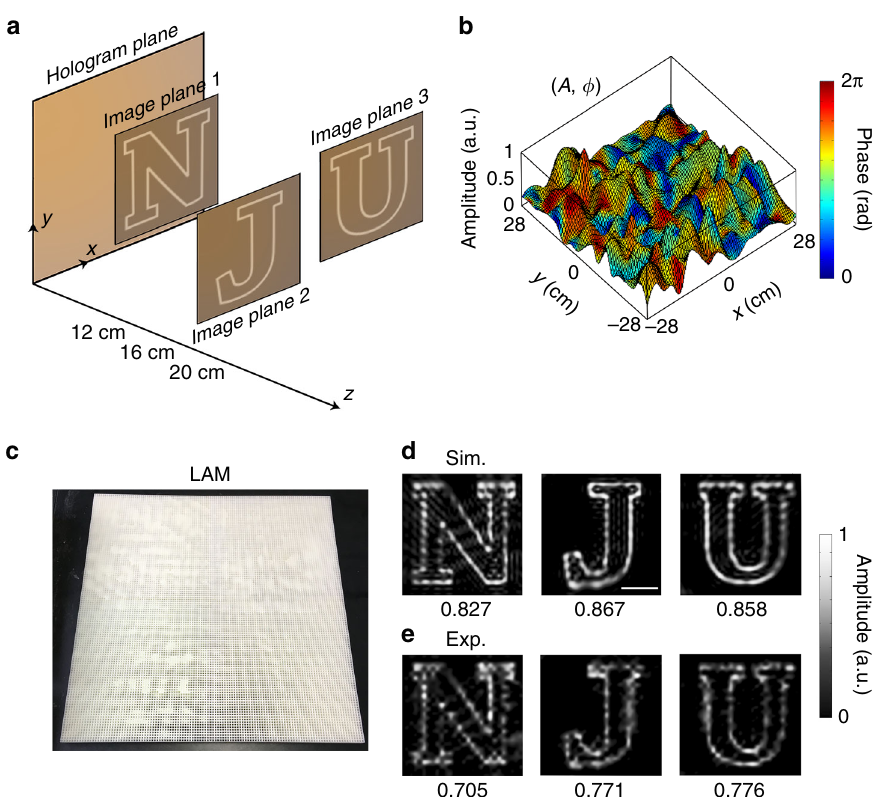
Fig. 6 Experimental veri fi cation of multi-plane acoustic hologram. a The predesigned image of a multi-plane acoustic hologram (letters “ N, ” “ J, ” and “ U ” at different distances of 12, 16, and 20 cm). b Amplitude and phase pro fi les on the hologram plane for projecting the “ N, ” “ J, ” “ U ” images at multiple planes. c The photograph of the 3D printed LAM sample. d , e The simulated holographic images by the APM method and the corresponding experimentally measured results. The correlations are marked in the fi gure. The correlation between the resulting image and the predesigned image is appended below each sub- fi gure. Scale bar, 10 cm. Rights for use of the NJU font images in this fi gure are from Adobe Font Software License: https://www.fontspring.com/ lic/ztxtzqqpzi. All rights